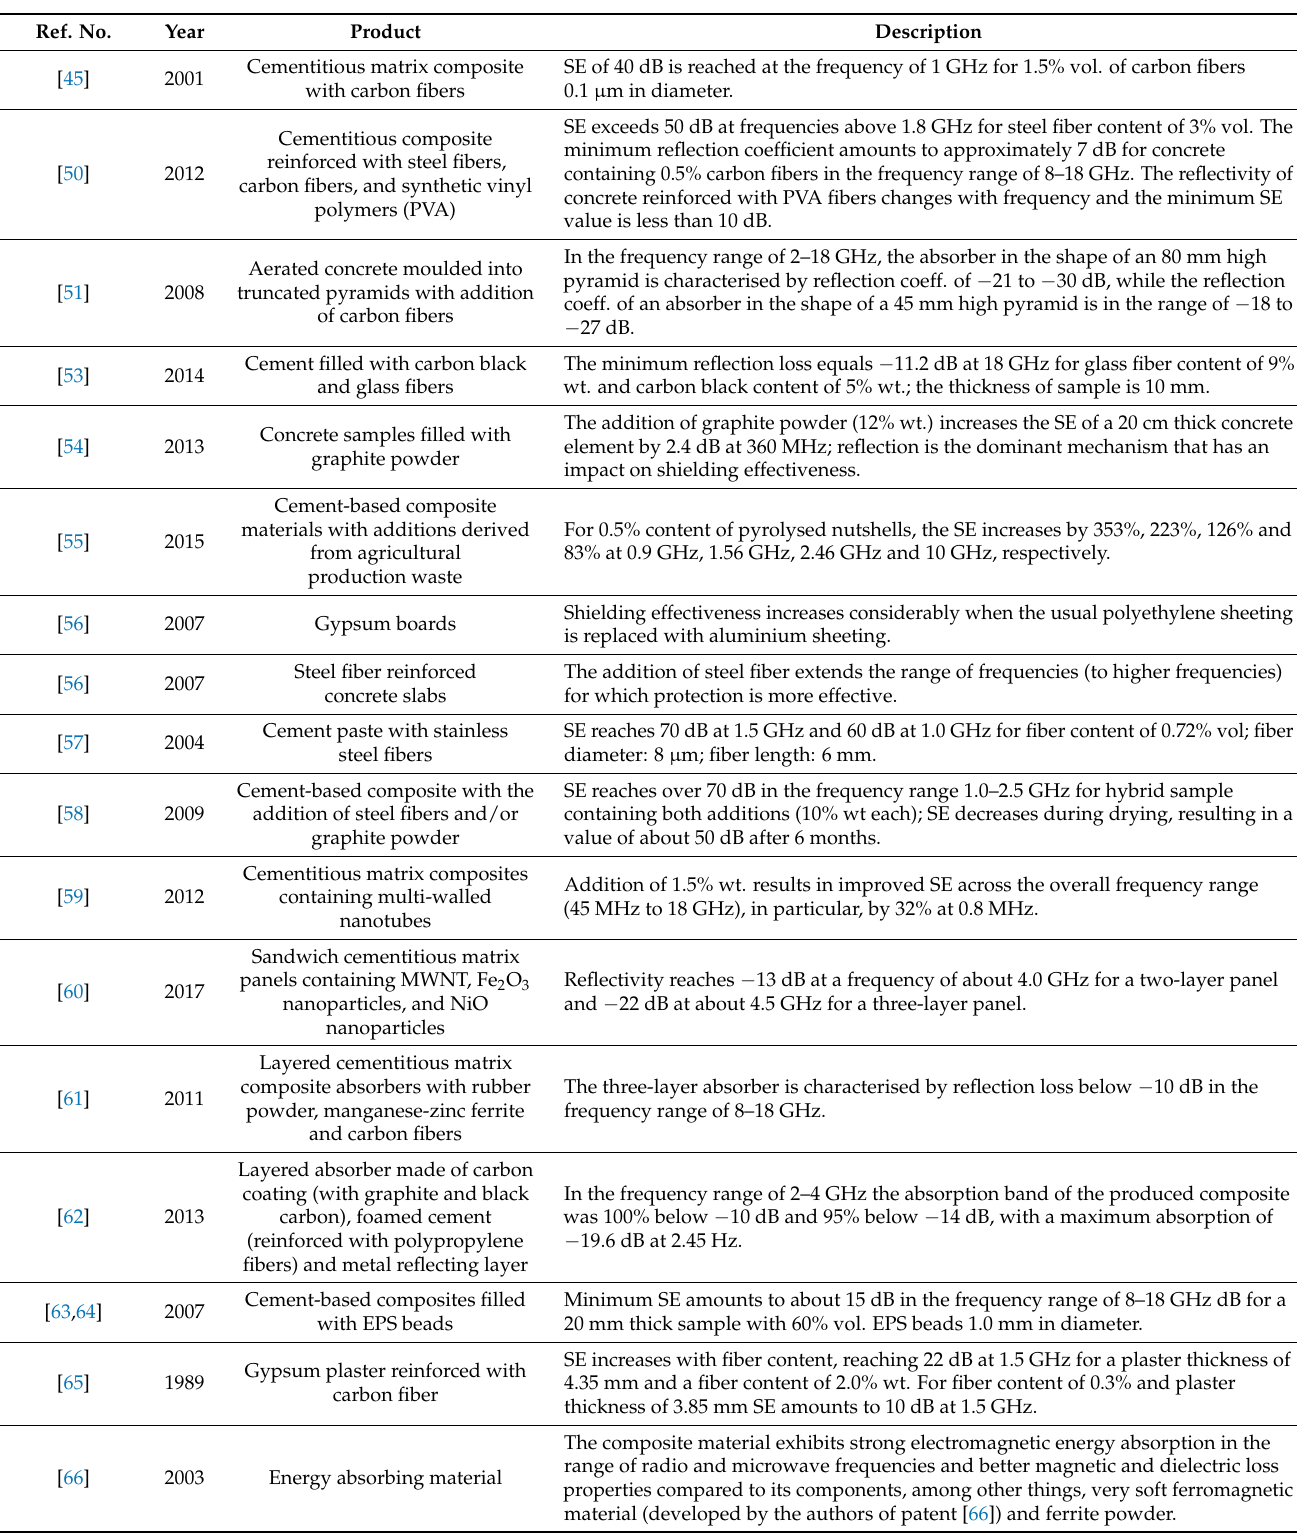
Table 4. Summary of the products described in Section